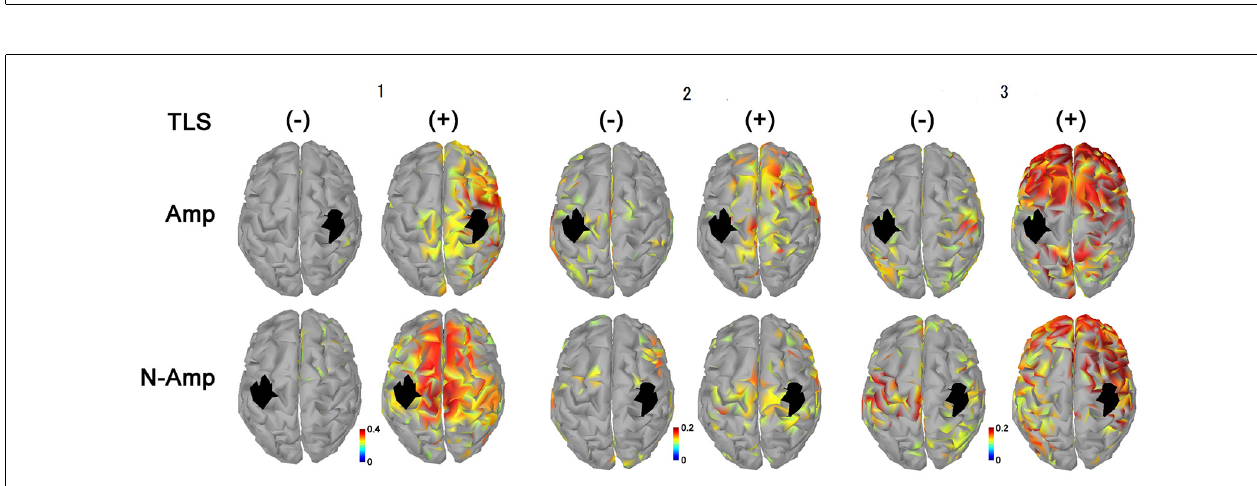
FIGURE 3 | Neural connectivity expressed as AEC values for alpha frequency band between the primary sensorimotor area for arm and hand (S1, black areas) and other brain areas without [TLS ( − )] and with [TLS (+)] in the three participants. AEC values between S1 contralateral (upper row; Amp) and ipsilateral (lower row; N-amp) to the arm amputated and other areas are shown. All participants had increased AEC values in the condition with TLS activation between both SI and other brain areas. Differences between Amp and N-amp sides were not obvious in participants. AEC, amplitude envelope correlation; TLS, Tacit Learning System.